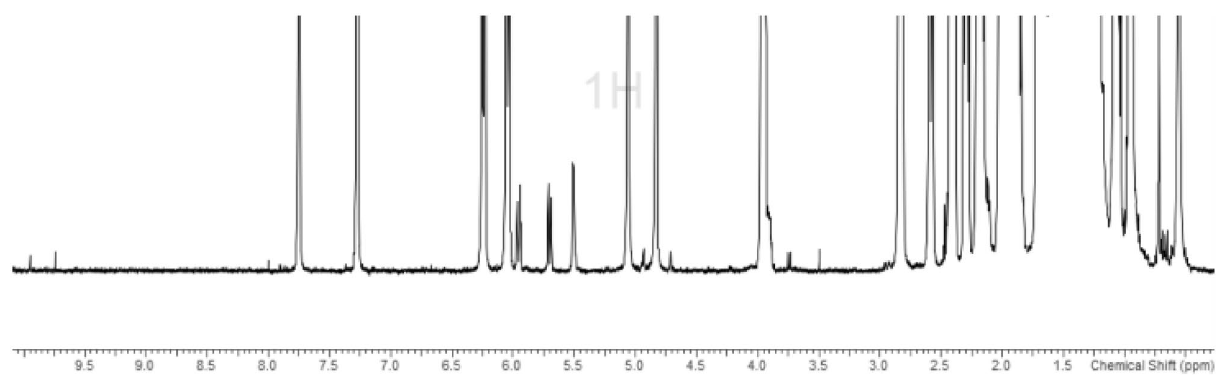
Figure 4. New signals after 56 h in the CDCl 3 solution of molecule 25-hydroxyvitamin D3